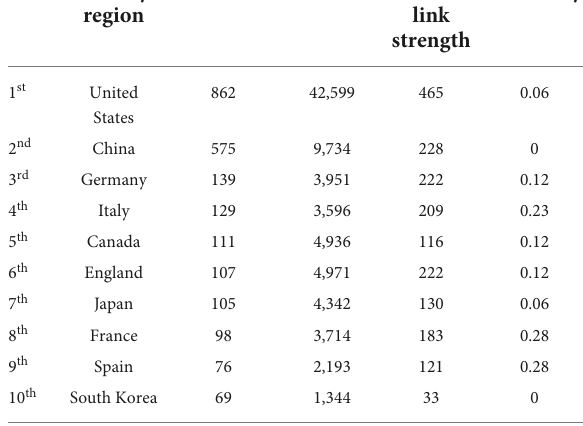
TABLE 1 Top 10 most productive countries and regions with publications on mammalian target of rapamycin (mTOR) in the field of neuroscience.